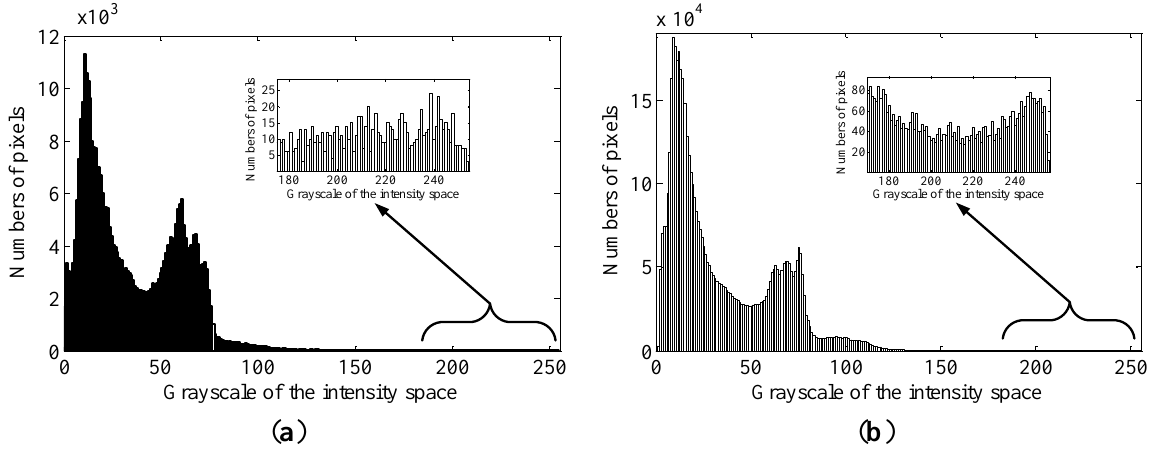
Figure 1. ( a ) Intensity histogram of a single frame; ( b ) Cumulative intensity histogram of consecutive fifteen frames.